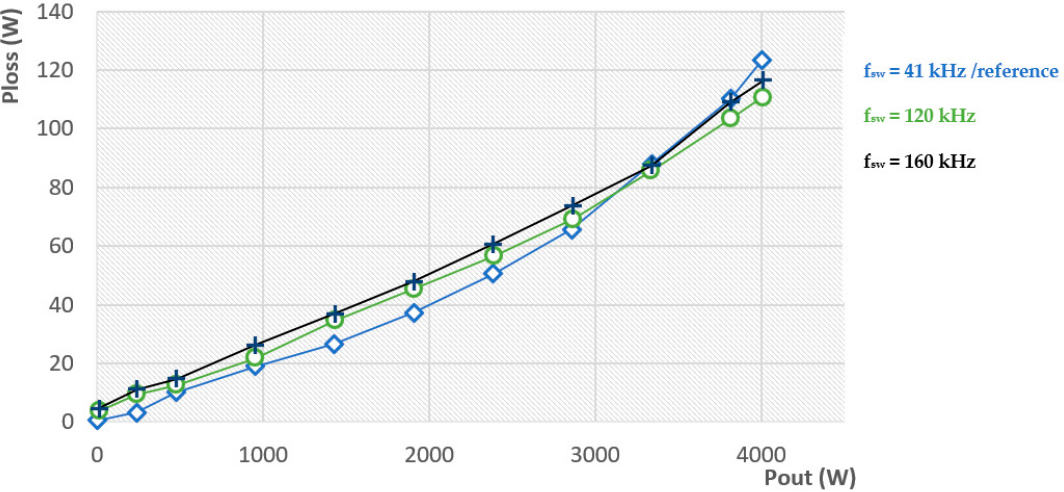
Figure 9. Total power losses of analyzed non-optimized PFC converter in dependency on the output power and switching frequency.